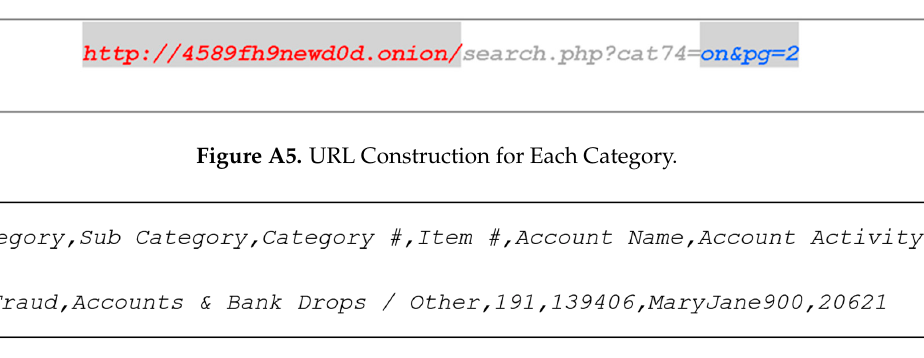
Figure A6. Output Format of Each Listing on Our Focus Marketplace.